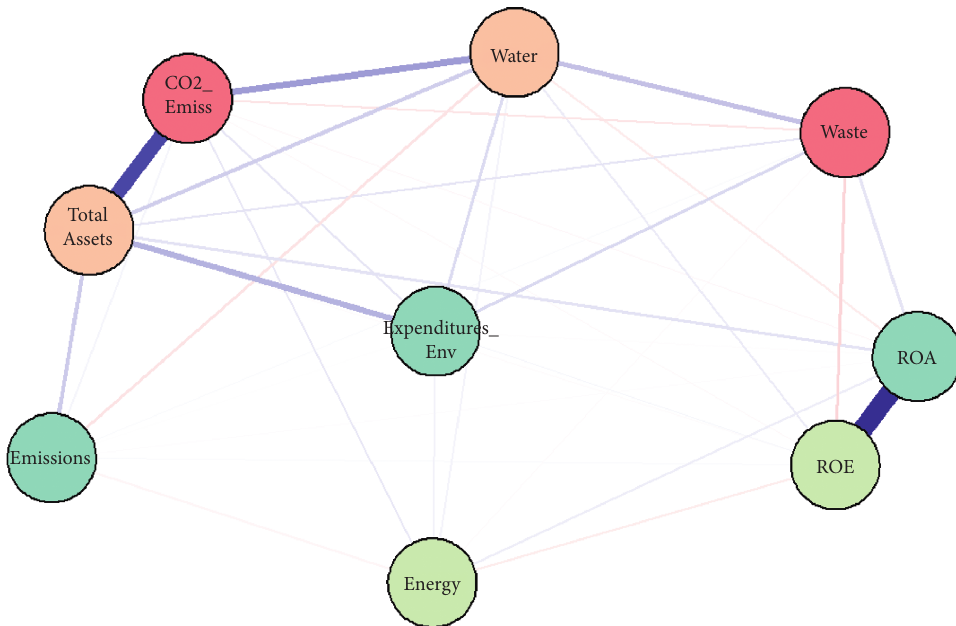
Figure 7: The association between the policy measures and the financial performance–GGM, for the oil and gas companies from the EEA, 2009–2018 Source : Own contribution in R program.